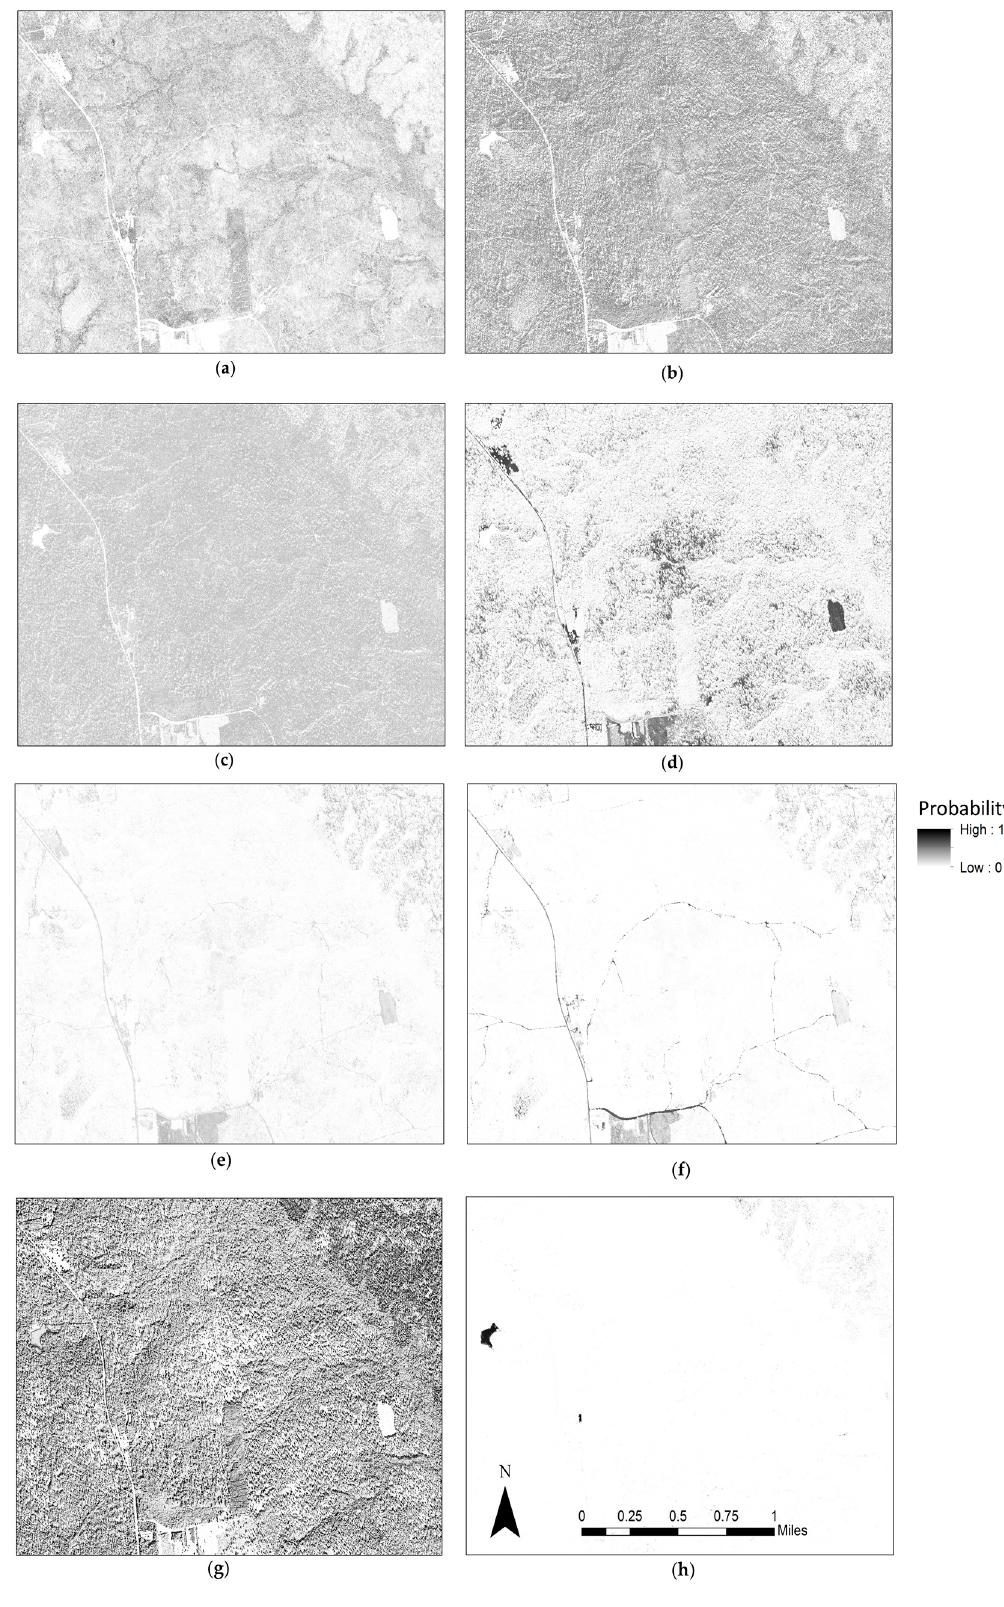
Figure 4. Comparison of probabilistic classification outputs: ( a ) ‘tree crown dark’ (our coniferous tree class); ( b ) tree crown light (our deciduous tree class); ( c ) shrub class; ( d ) green grass class; ( e ) dry grass class; ( f ) bare ground; ( g ) shadow class; ( h ) water class.